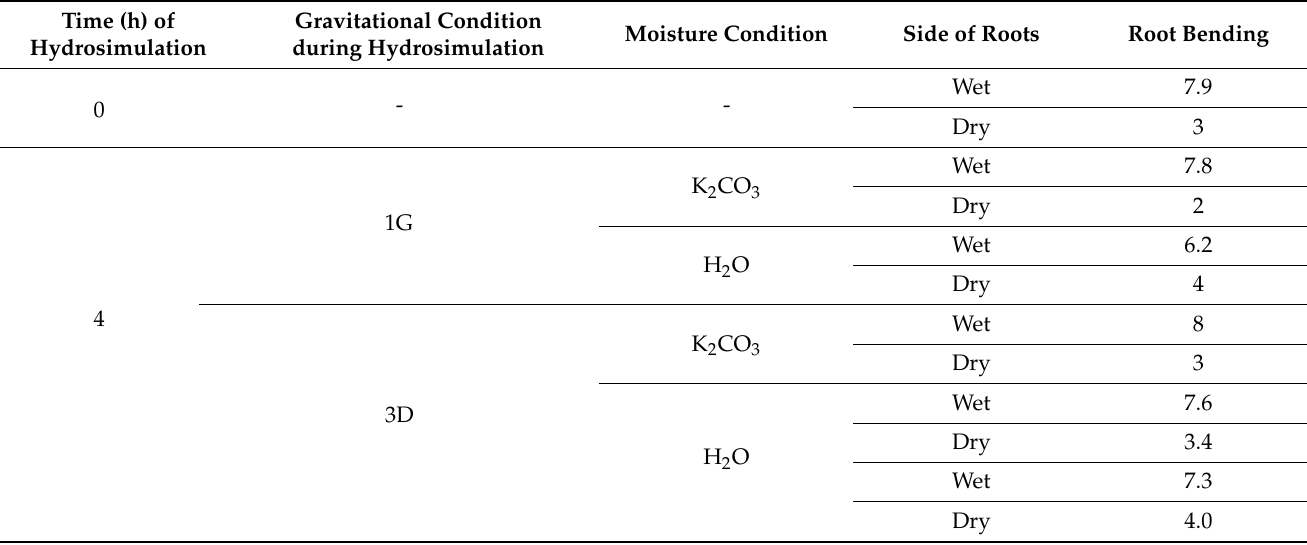
Table 2. Readings obtained from cucumber roots exposed to various water